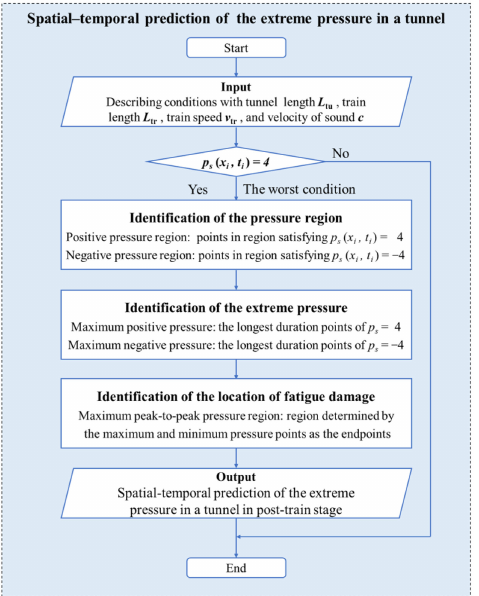
Figure 6. Flowchart of spatial–temporal prediction of the extreme pressure in a